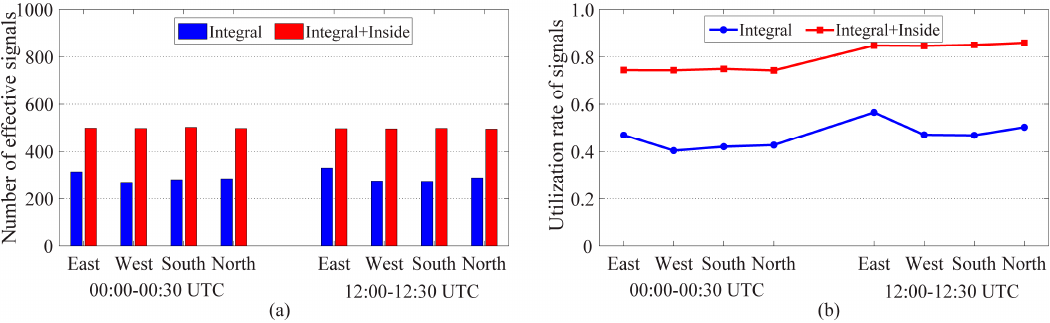
Figure 10. The number of penetrated signals in the RS-voxels column, where the abscissa represents the bottom-up column voxel numbering. (a) Scheme East; (b) Scheme West; (c) Scheme South; and (d) Scheme North. Figure 11. The average number of effective signals (a) and the mean utilization rate of signals (b) for the two methods during the period of DOY 213-243, 2017.